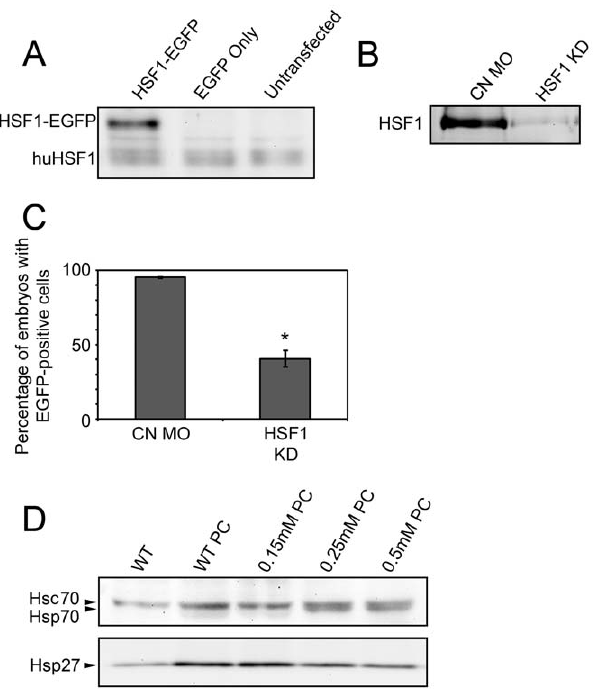
Figure 4. Assessment of HSF1 knockdown following HSF1 MO injection. A: Western blots of HeLa cell protein using the SPA-901 anti- Human HSF1 antibody. A single band is seen at the predicted molecular weight of human HSF1 (huHSF1) in all lanes. An additional higher molecular weight band is detected in extracts of cells transfected with plasmid coding for a zebrafish HSF1-EGFP fusion protein (left lane), but not EGFP alone (middle lane). B: Western blot of HSF1 in nuclear extracts of 48 hpf zebrafish embryos. Embryos were injected with control (CN MO) or anti-HSF1 (HSF1 KD) MO. C: Quantification of the number of embryos containing fluorescent cells following co-injection of a HSF1-EGFP reporter plasmid and control (CN MO) or HSF1 antisense (HSF1 KD) MO. Error bars are the SEM. The asterisk indicates a statistically significant difference between a -HSF1 and CN-MO injected embryos. D: Effect of a -HSF1 MO on heat shock protein expression after heat shock preconditioning (PC). Embryos were injected with the indicated concentrations of a -HSF1 MO or uninjected (WT), followed by Western blotting for the detection of Hsp70 and Hsp27.